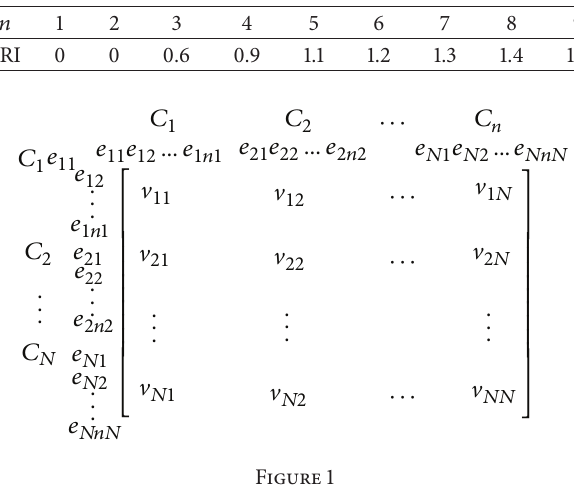
The “consistency index (CI)” and “consistency